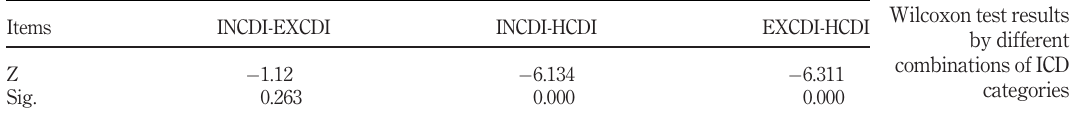
Table 8. Wilcoxon test